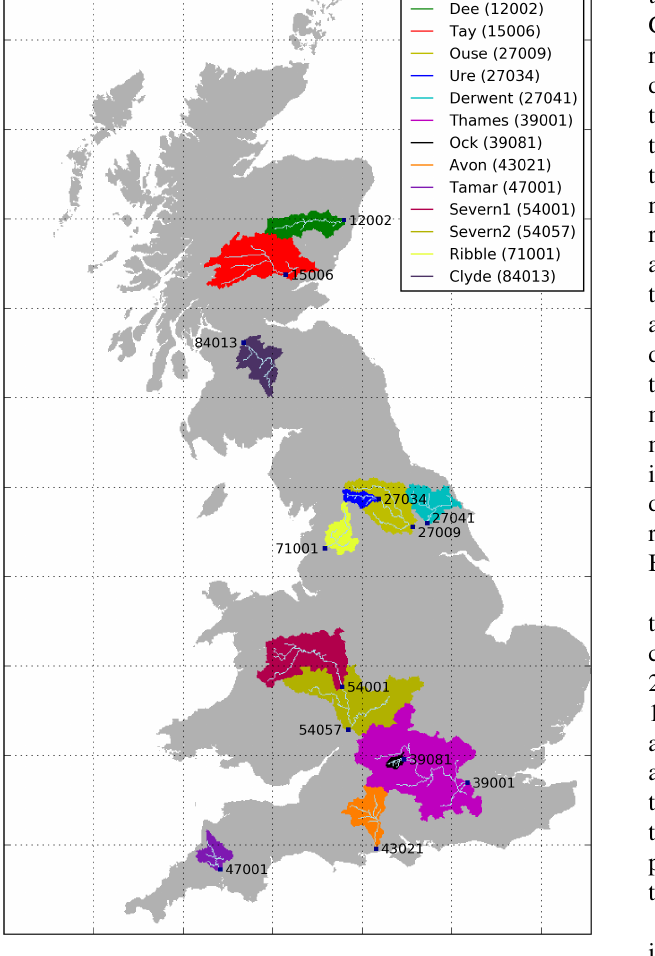
Figure 1. Thirteen selected catchments in Great Britain and their main flow pathways. The outlet stations are represented by a dark-blue dot and identified by their National River Flow Archive (NRFA) station number. Note that Ure, Severn1 and Ock are subcatchments within the larger catchments Ouse, Severn2 and Thames,